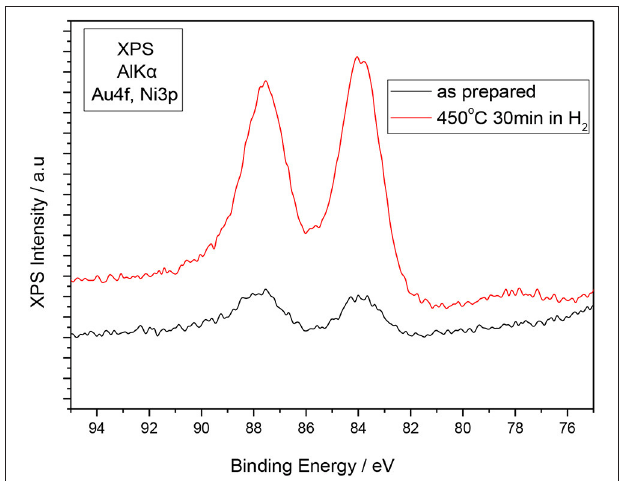
FIGURE 7 | XPS of Au on Ni-Au(10 wt%)/GDC before and after the reduction of the sample at 450 ◦ C for 30min. The oxidized sample was pretreated at 1100 ◦ C for 90min.